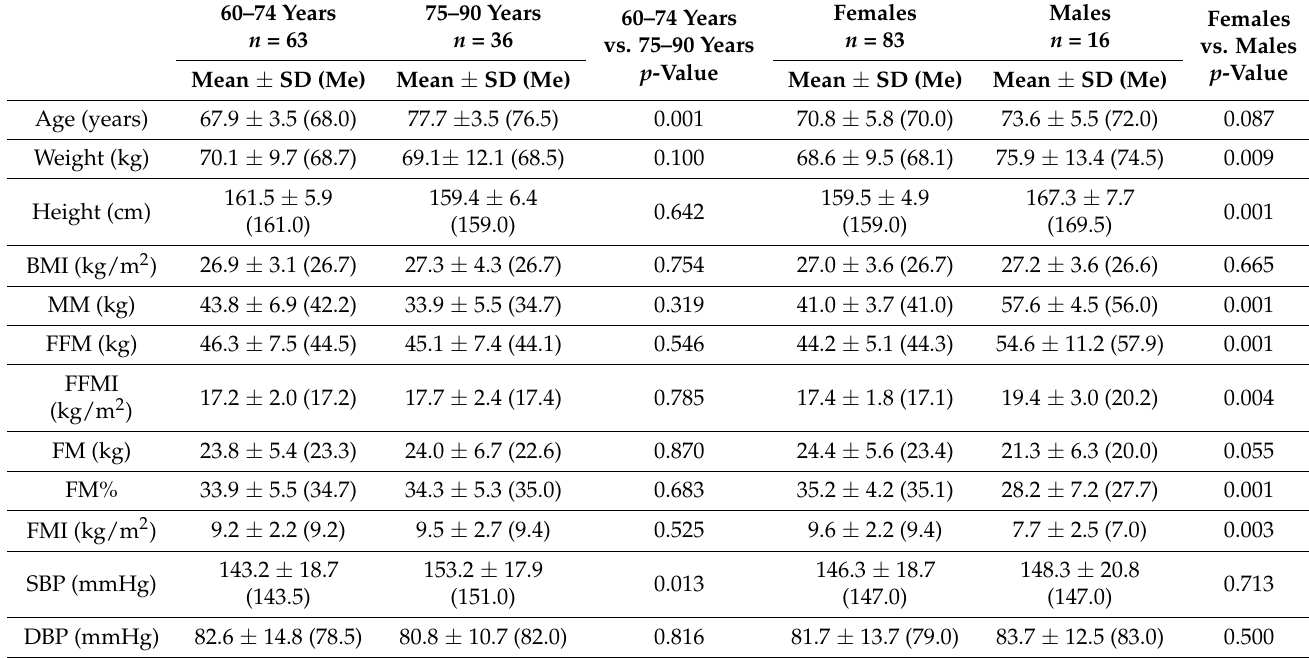
Table 2. Anthropometrics and body composition differences between 60–74 years and 75–90 years as well as between women and